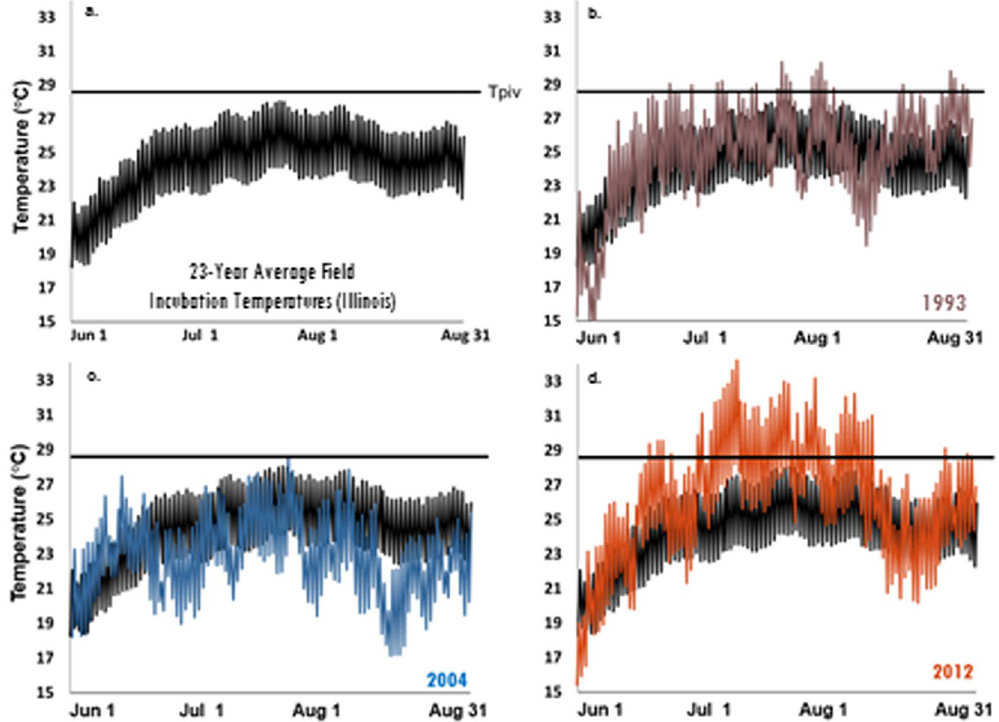
Figure 1. Sub-surface soil temperatures from Peoria, Illinois 34 . In all figures, the Tpiv of Trachemys scripta is demarcated with a flat line. ( a ) The 23-year average soil temperatures during the breeding and incubation season never rise above the Tpiv. Temperature traces from individual years are compared to the 23-year average in panels B–D. Panel B is a representative thermal trace of temperatures most frequently observed. Note that temperatures periodically rise above the Tpiv for brief periods of time. Panel C is a representative cool year, and panel D. is an anomalous warm year.